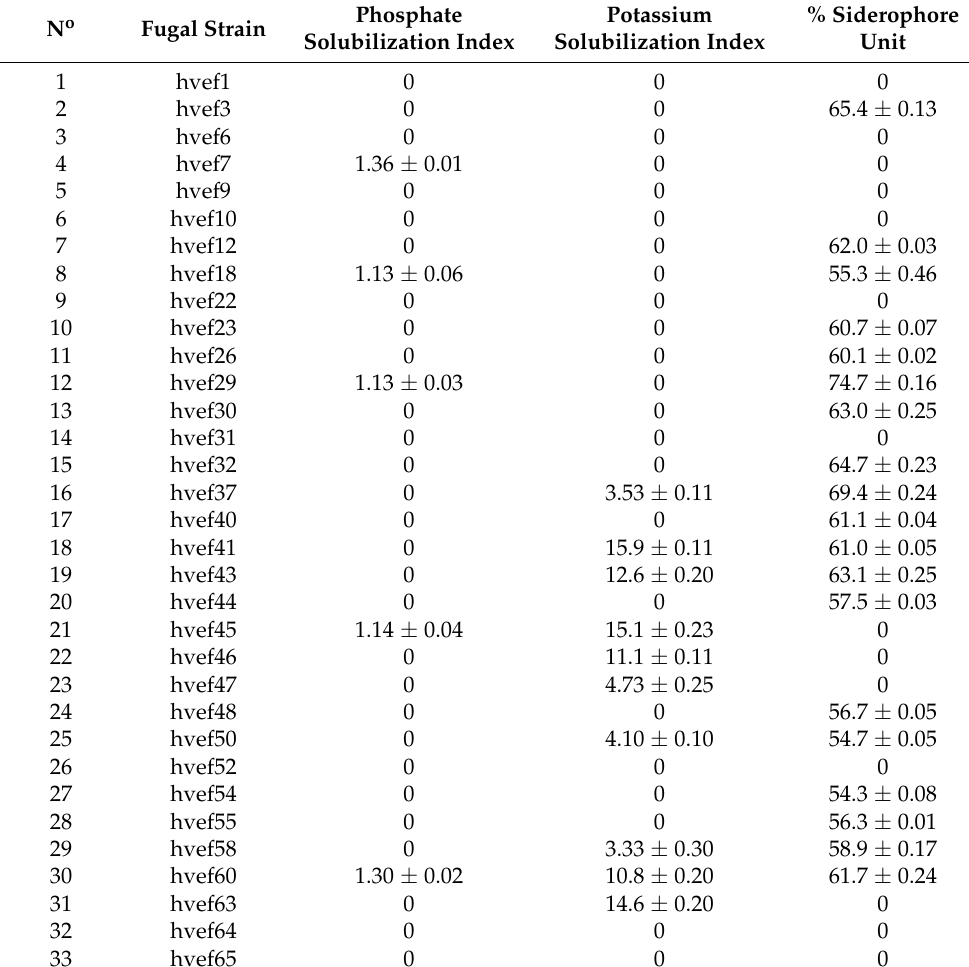
Table 2. Phosphate and potassium solubilizing activities and siderophore production of endophytic fungal strains isolated from V. villosa